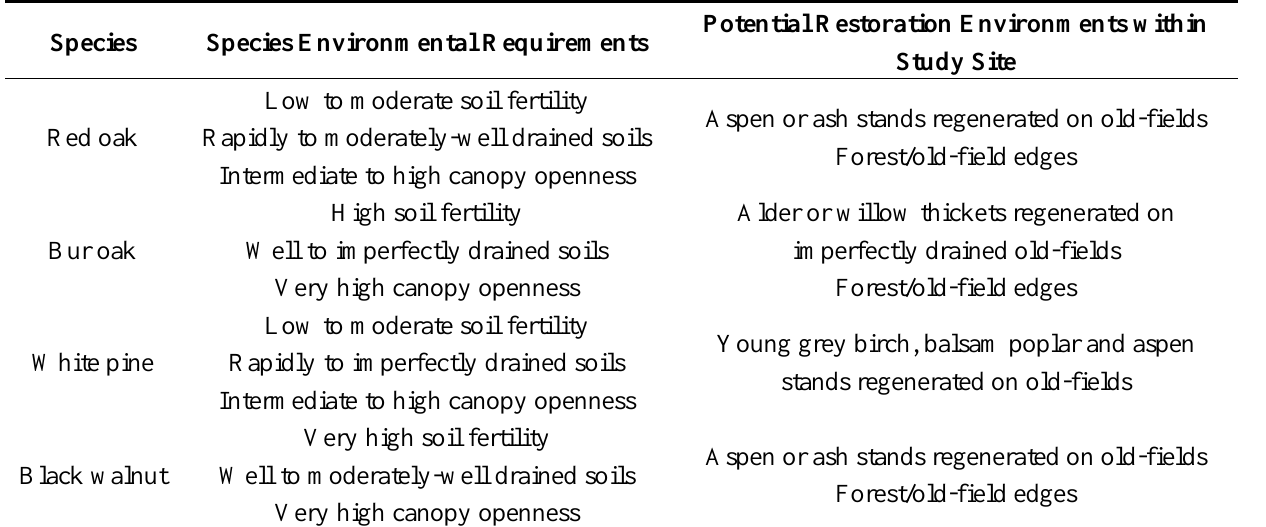
Potential Restoration Environments within Aspen or ash stands regenerated on old-fields